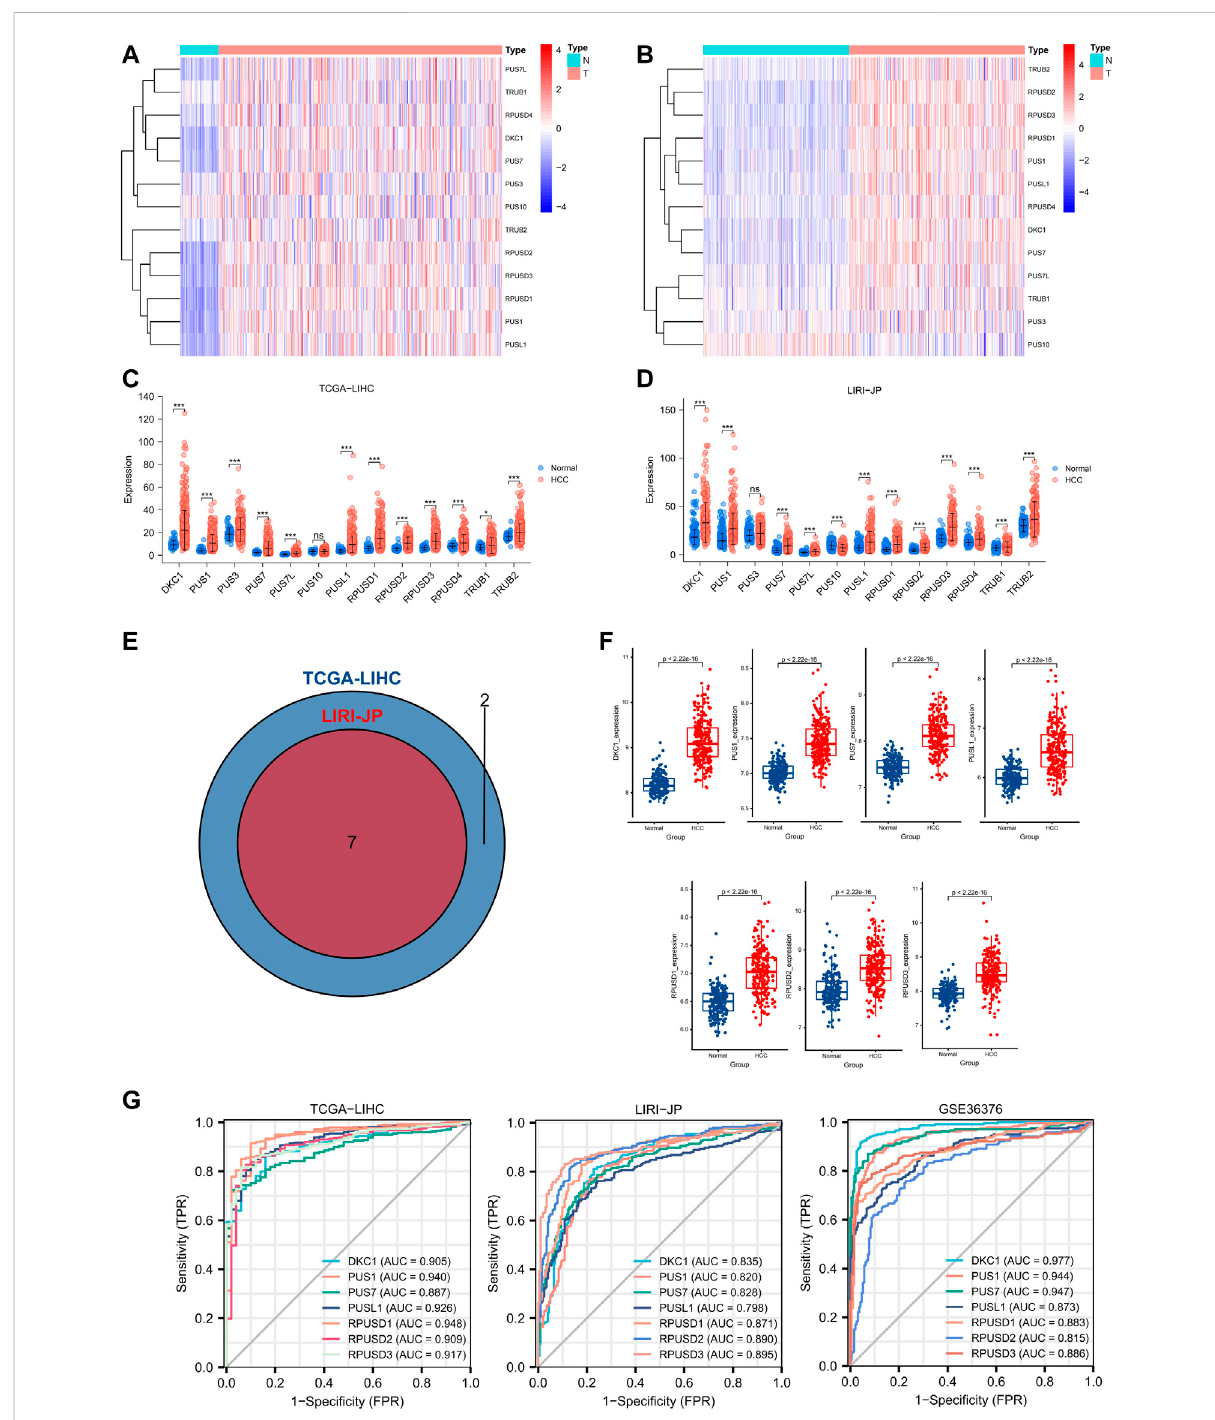
FIGURE 2 Expression pro fi le and diagnostic value of PUSs mRNA in HCC. (A – B) Heatmap of PUSs expression in TCGA-LIHC (A) and LIRI-JP (B) ; (C – D) Expression difference of PUSs between non-cancerous tissues and HCC in TCGA-LIHC (C) and LIRI-JP (D) ; (E) Venn diagram of differentially expressed PUSs in TCGA-LIHC and LIRI-JP; (F) Expression of seven differentially expressed PUSs between non-cancerous tissues and HCC in GSE36376; (G) ROC curves of PUSs expression in three HCC cohorts. (ns: no statistical signi fi cance, * p < 0.05, ** p < 0.01, and *** p <